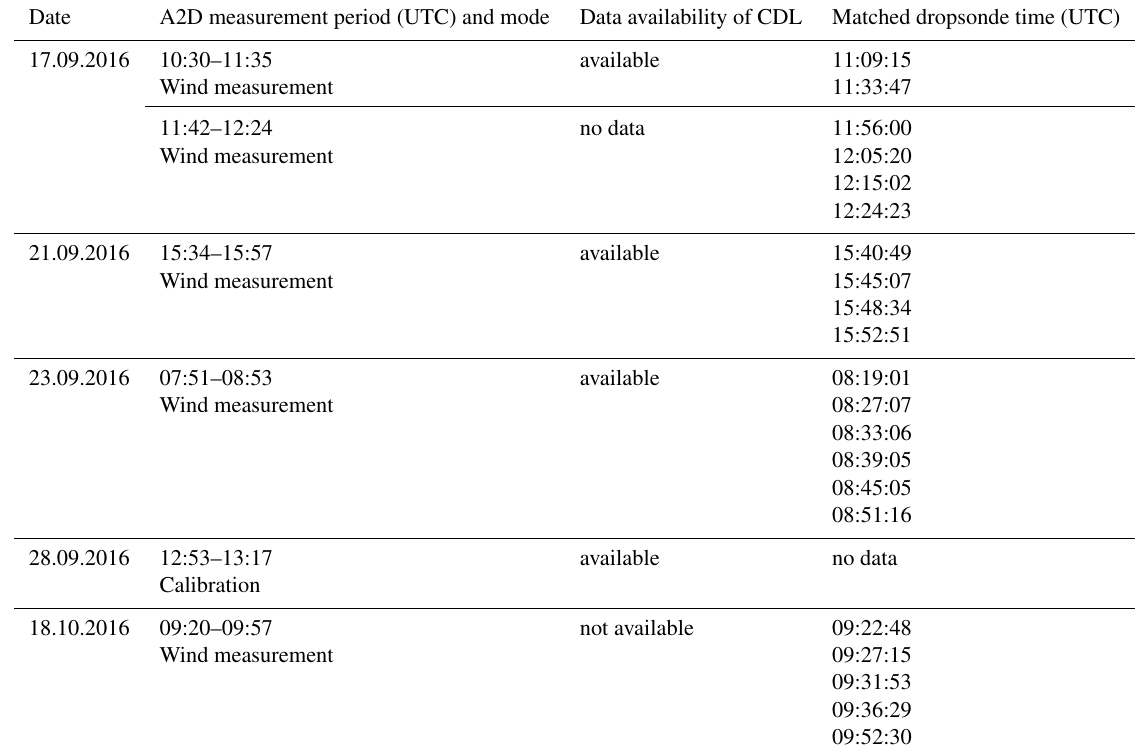
Table 2. Overview of analyzed datasets from A2D, 2µm CDL, and dropsondes in the frame of the North Atlantic Waveguide and Downstream Experiment (NAWDEX)